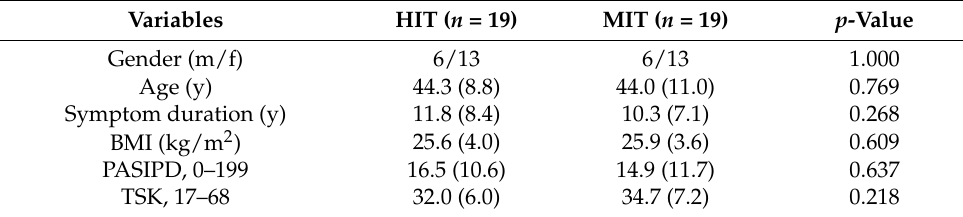
Table 2. Demographic and clinical characteristics of participants at baseline ( n =